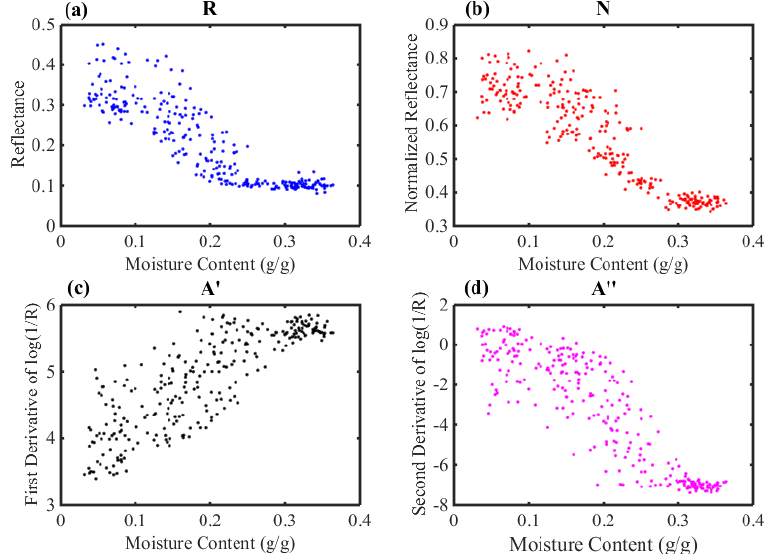
Figure 4. Reflectance for wavelength of 1900 nm of ( a ) Reflectance (R); ( b ) Normalized Reflectance (N); ( c ) First Derivative of log(1/R) (A ′ ) and ( d ) Second Derivative of log(1/R) (A ″ ) with increasing soil moisture content for SL + C + SC samples.